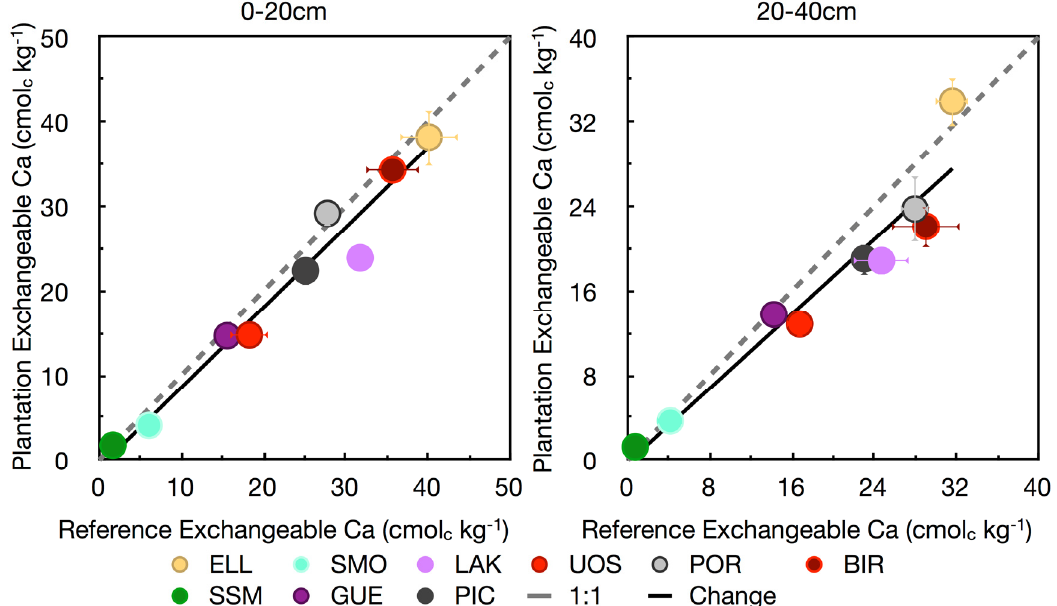
Figure 5. Initial concentration of exchangeable Ca, as estimated from reference sites, versus exchangeable Ca concentration in plantations after the first rotation of nine S . purpurea “Hotel” plantations (ELL, SMO, LAK, UOS, POR, BIR, SSM, GUE, and PIC). Error bars represent standard error when greater than symbol